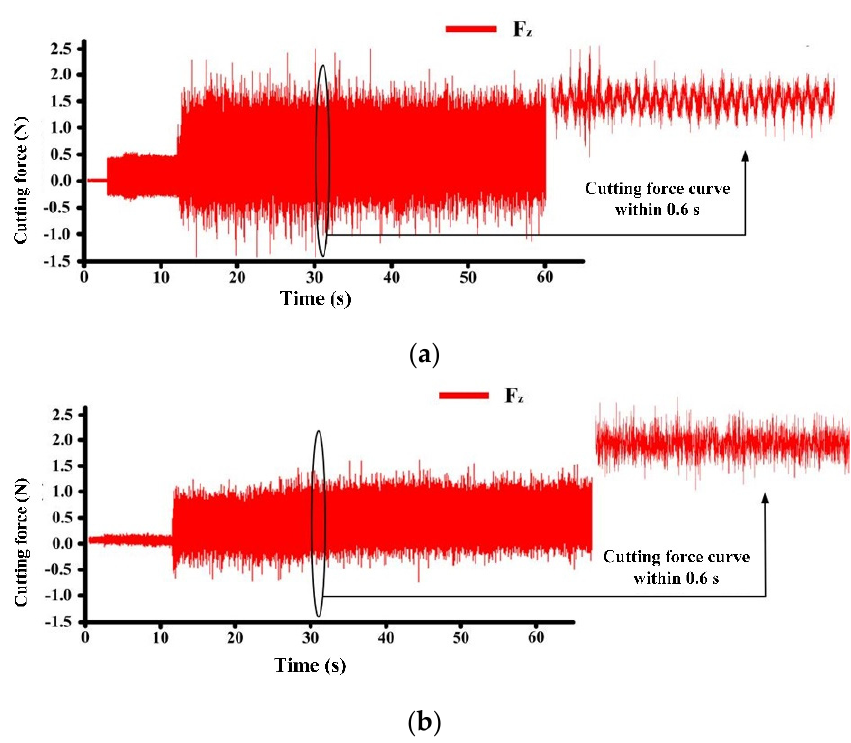
Figure 13. Main cutting force of non-textured PCD tool ( a ) and textured PCD tool ( b ) in turning experiment.